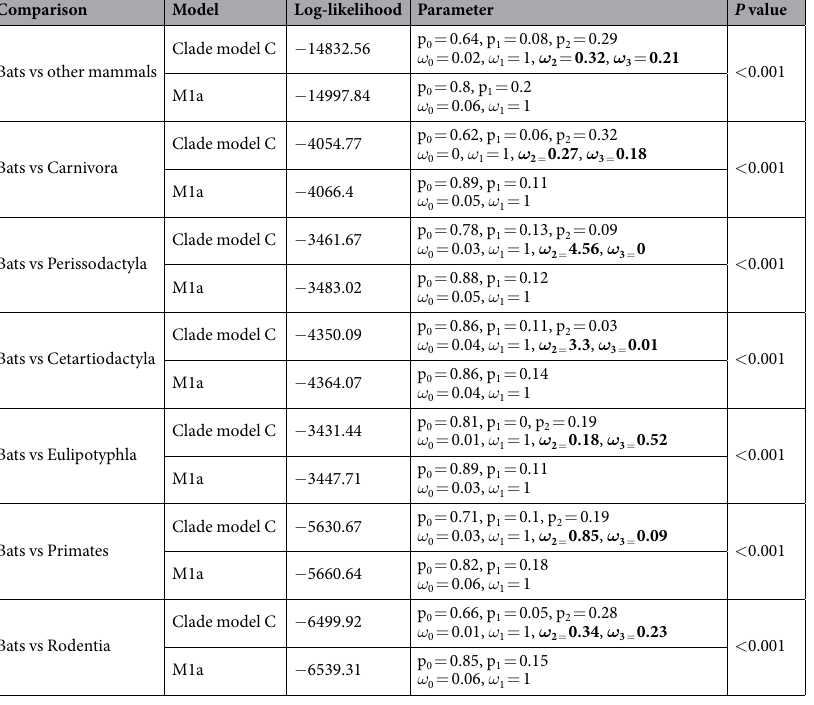
Table 1. Selective pressures on SWS1 genes from bats and other mammalian groups. The estimated ω 2 and ω 3 values for background and foreground clades are shown in